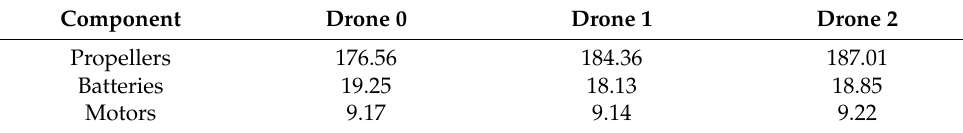
Table 8. Expected number of maintenance cycles for each module of UAV